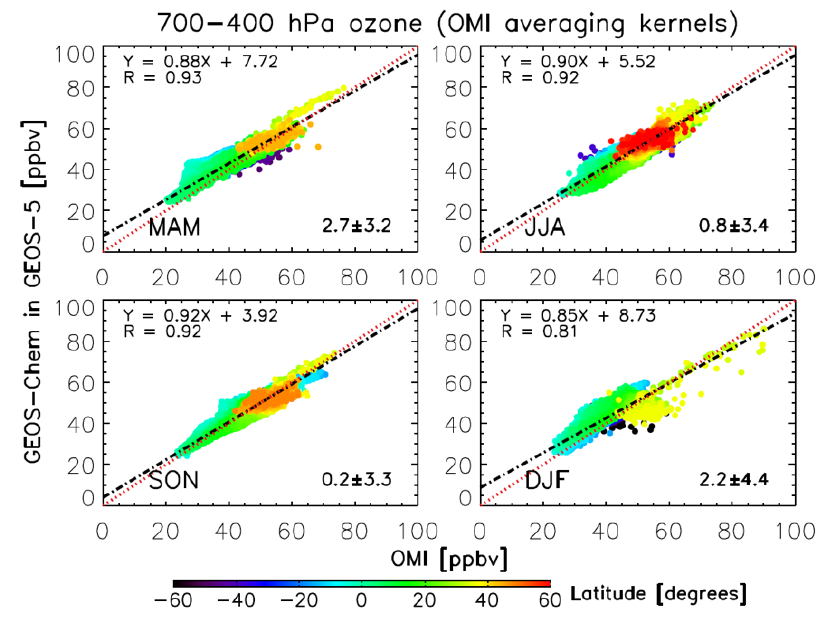
Figure 4. Comparison of GEOS-5 Nature Run with GEOS-Chem chemistry to OMI 700–400hPa ozone measurements for four seasons in July 2013–June 2014, colored by the latitude of the observations. Each point represents the seasonal mean for a 2 ◦ × 2 . 5 ◦ grid cell. Black dashed lines show the best fit (reduced major axis regression) with regression parameters given in the inset. Numbers on the bottom right are the global mean model bias ± standard deviation. The 1 : 1 line is shown in